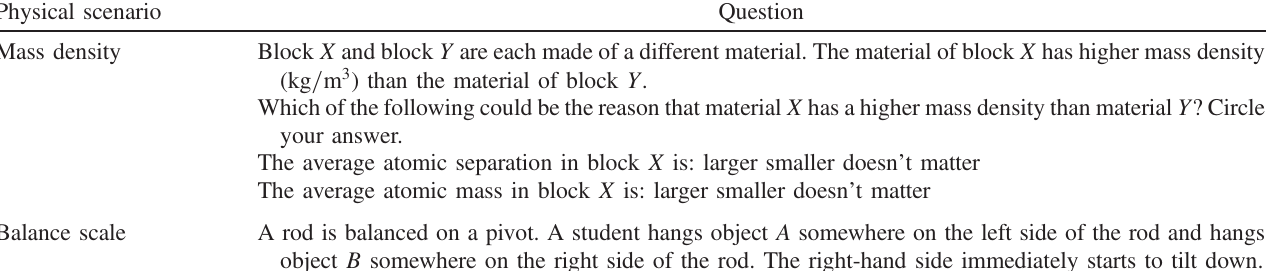
TABLE II. Experiment 1 recognize condition questions. Comparison such as “ larger ” means larger with respect to the other object in the scenario. Physical scenario Question Mass